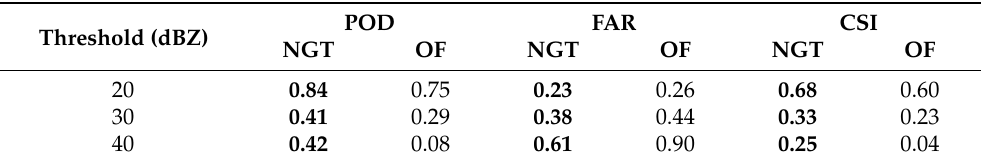
Figure 6. CSI of the prediction by NGT and OF for ( a ) Z > 20 dBZ, ( b ) Z > 30 dBZ, ( c ) Z > 40 dBZ, and ( d ) NGT—OF. The prediction starts at 9:05 UTC on 20 May 2011. The “static ref.” lines mean a reference without any extrapolation on the data of the starting time. Table 1. Skill scores of the two methods for 60 min prediction. The target time is 10:05 UTC on 20 May 2011.